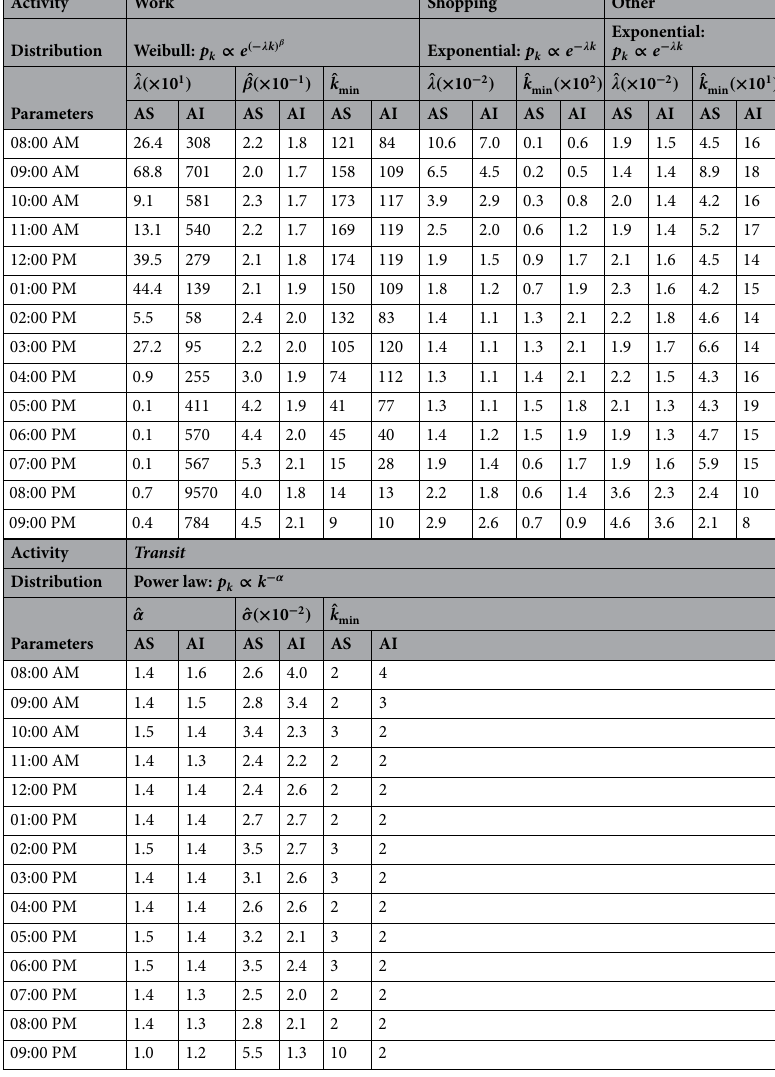
Table 2. Estimated parameters for fitted degree distributions of activity-based contact networks in Auto Sprawl (AS) and Auto Innovative